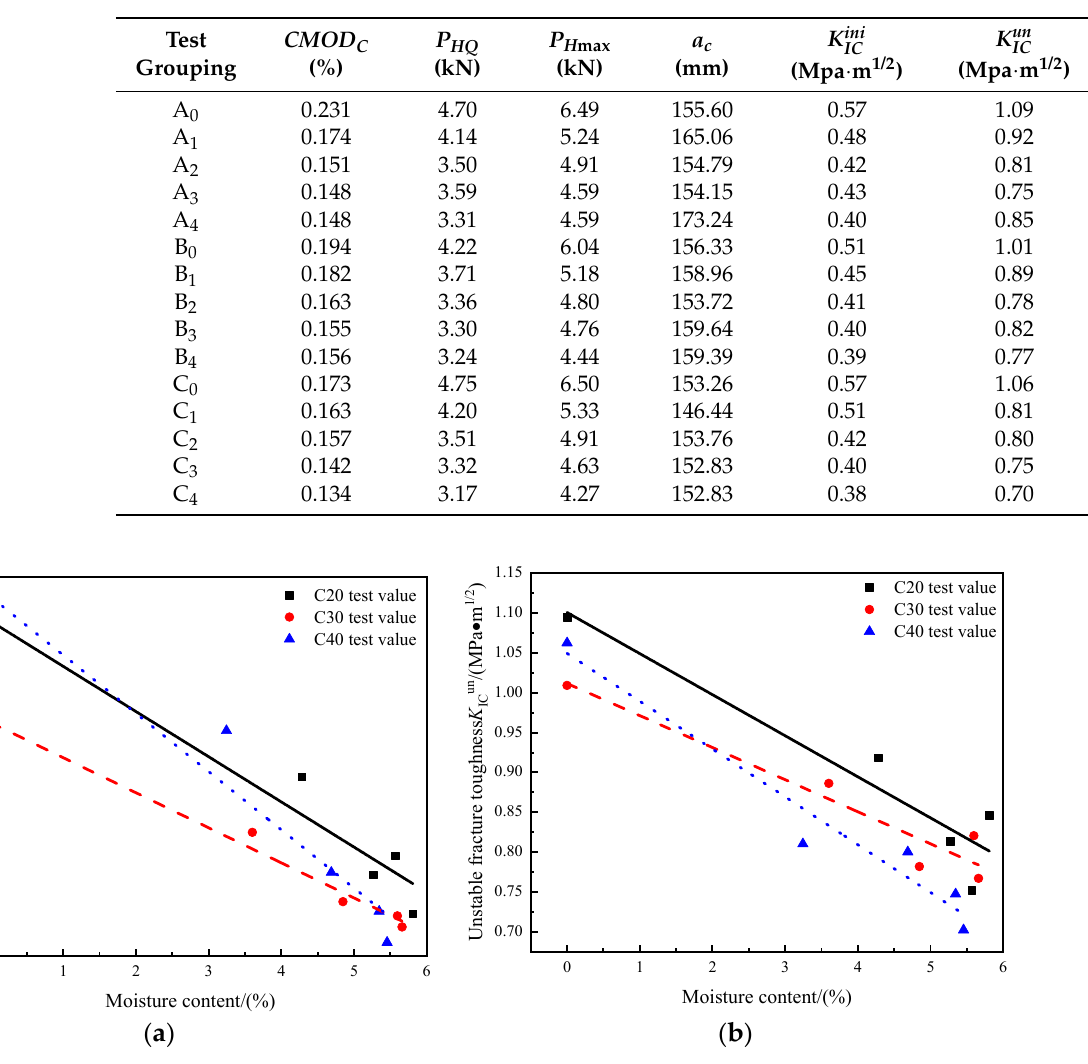
Table 4. Fracture parameters of concrete specimens with different moisture content.